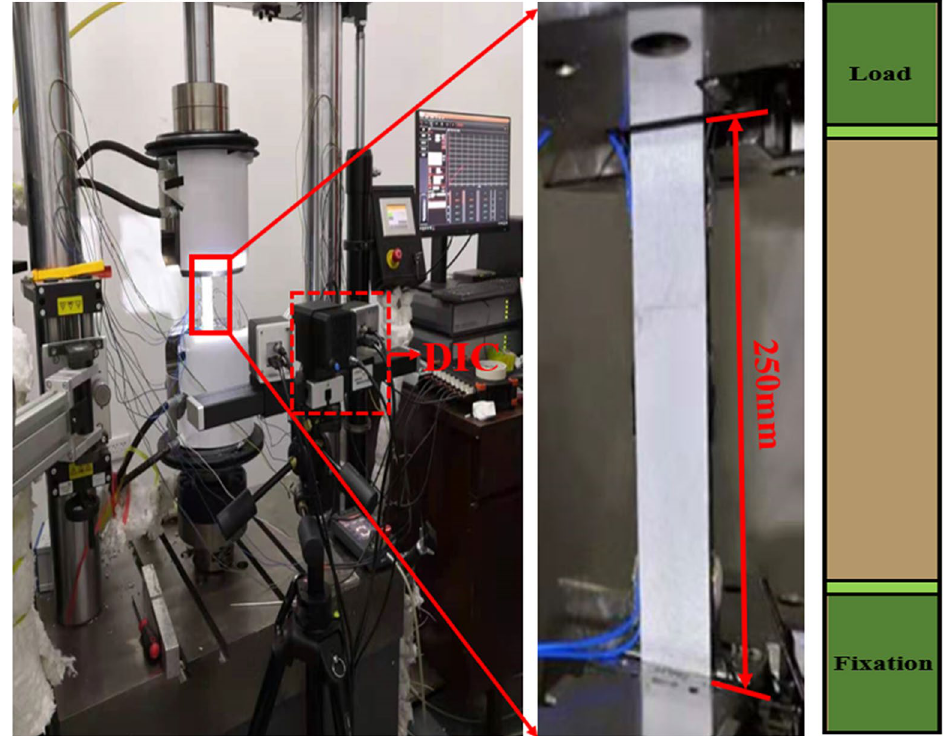
Figure 1. Loading form and testing device for basic mechanical properties of laminates.